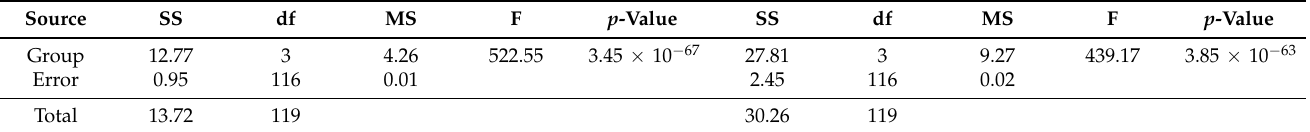
Table 8. ANOVA results of the left side columns are obtained from the dual signals based SVR-AF, LSTM-AF, GBA-AF, and EGPR-AF models; ANOVA results of the right side columns are acquired from the dual signals based SVR-FF, LSTM-FF, GBA-FF, and EGPR-FF models, where SS is the sum of squares and df is the degrees of freedom. The total degree of freedom is 120 (=119-1) minus 1 from the total number of measurements (MAE).